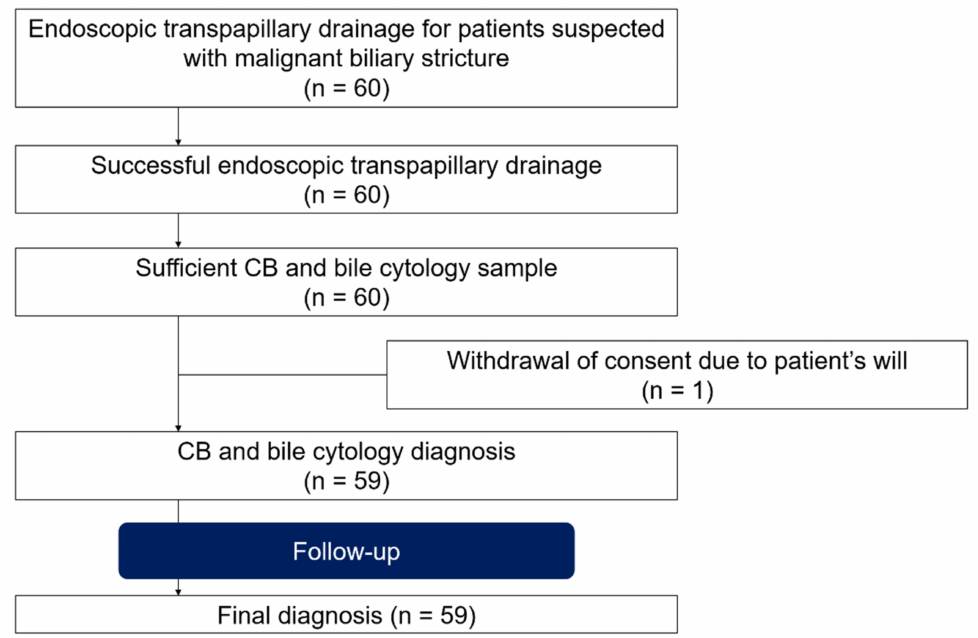
Figure 1. Study patient